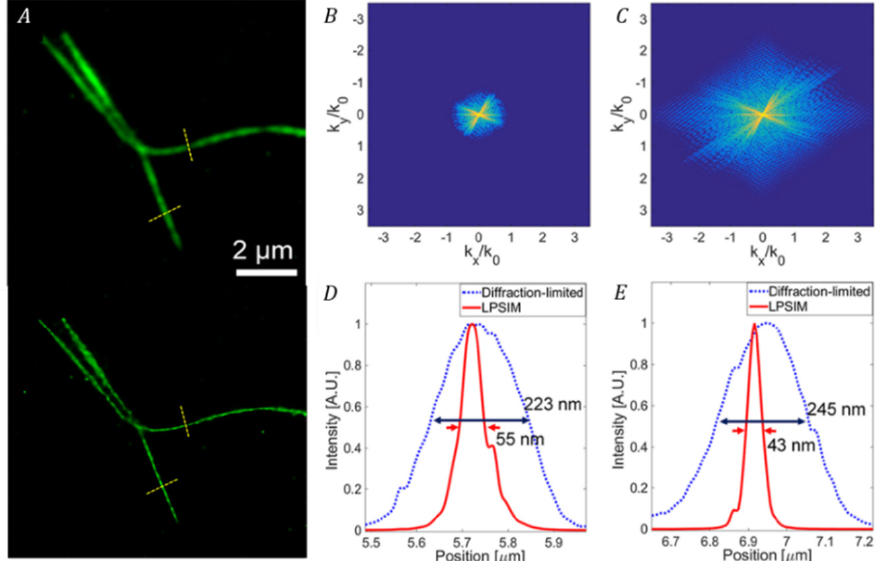
Figure 14. ( A ). LPSIM (bottom) and conventional fluorescence microscopy(top) for imaging microtubules. ( B , C ). Spatial frequency spectra of conventional fluorescence microscopy and LPSIM, respectively. ( D , E ) Normalized intensity profiles from the images in ( A ), respectively, along the dashed yellow lines. The LPSIM technique provides an approximately five-fold increase in resolution [122]. Copyright 2018 ACS Nano.